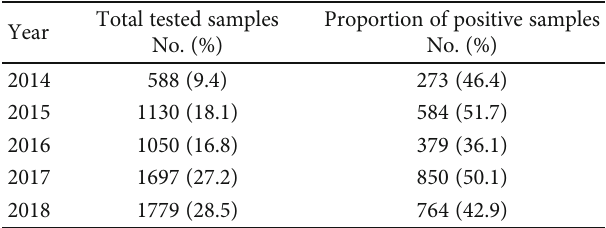
Table 1: Prevalence of intestinal parasites across years among students attending University of Gondar students ’ clinic, 2014 –